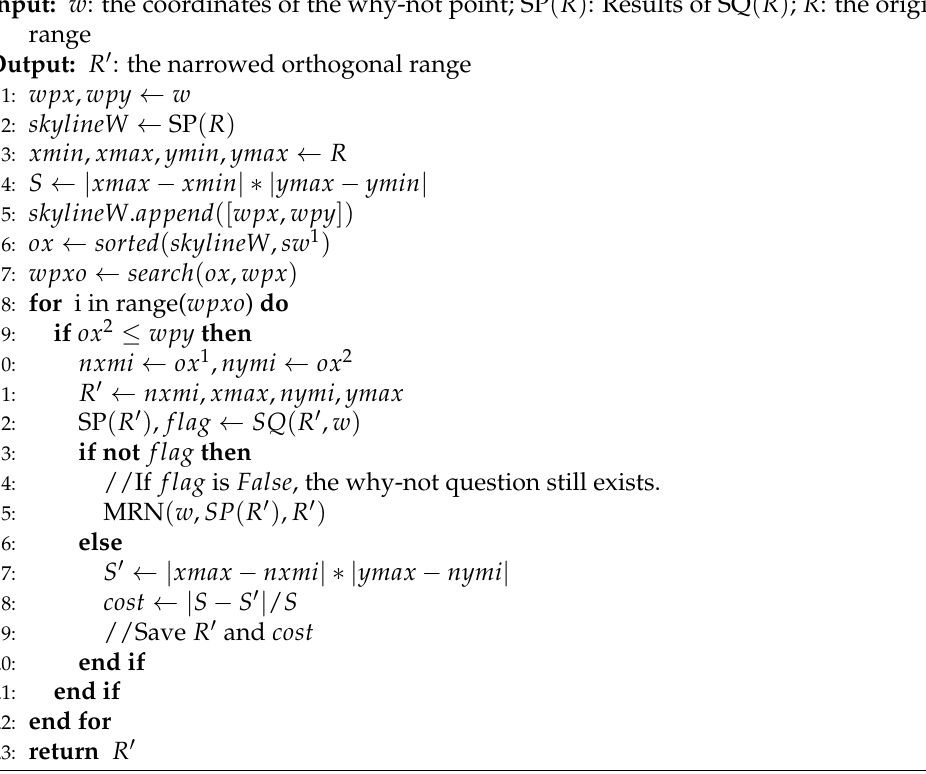
Algorithm 3 MRN ( w , SP ( R ) , R